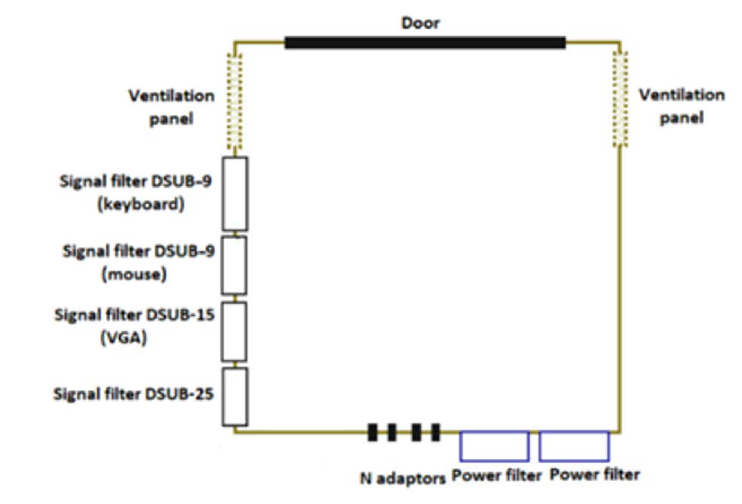
Figure 7. Shielding enclosure schematics.